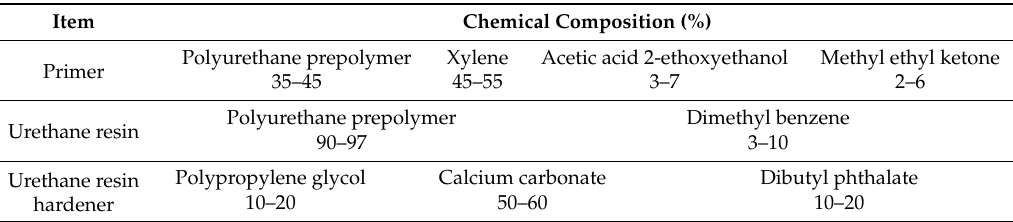
Table 3. Chemical composition of urethane surface finisher.